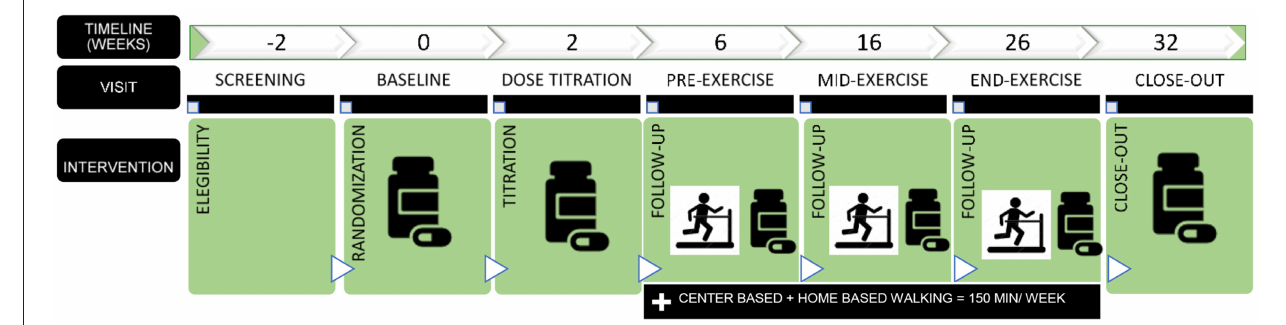
FIGURE 1 | Design overview. Participants will be randomized to one of three first-line antihypertensive medications: (a) perindopril (titration from 4 to 8 mg/day); (b) losartan (titration from 50 to 100 mg/day). If participants do not tolerate the higher study dose will remain in the lower dose of the study medication. (c) HCTZ (from 12.5 to 25